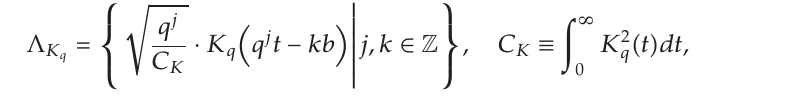
; (cid:2) d (cid:3) Cos wavelet approximation q j (cid:5) 0 Cos (cid:2) q (cid:5) 1 . 5, scale (cid:5) q 2 , shift (cid:5) 5 · b (cid:5) 12.2 (cid:3) ; (cid:2) f (cid:3) q Cos wavelet q